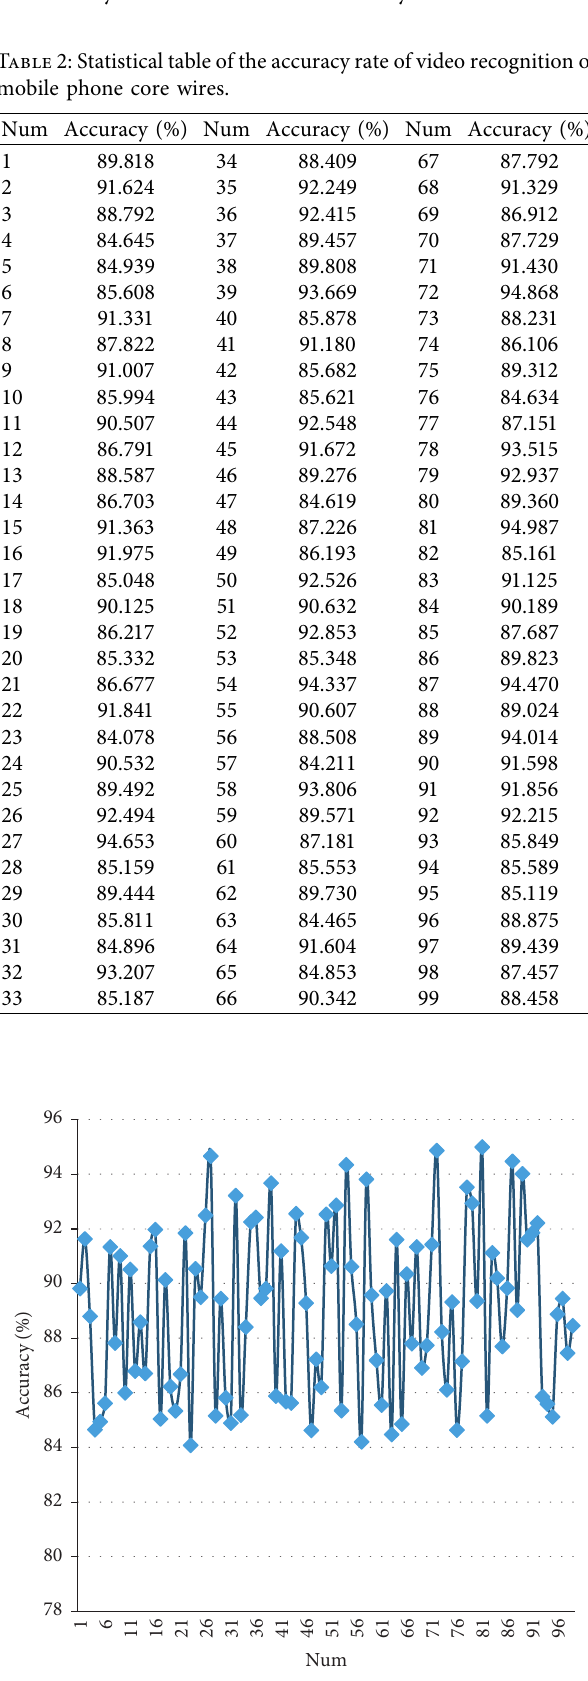
Figure 13: Statistical diagram of the accuracy rate of video rec- ognition of mobile phone core